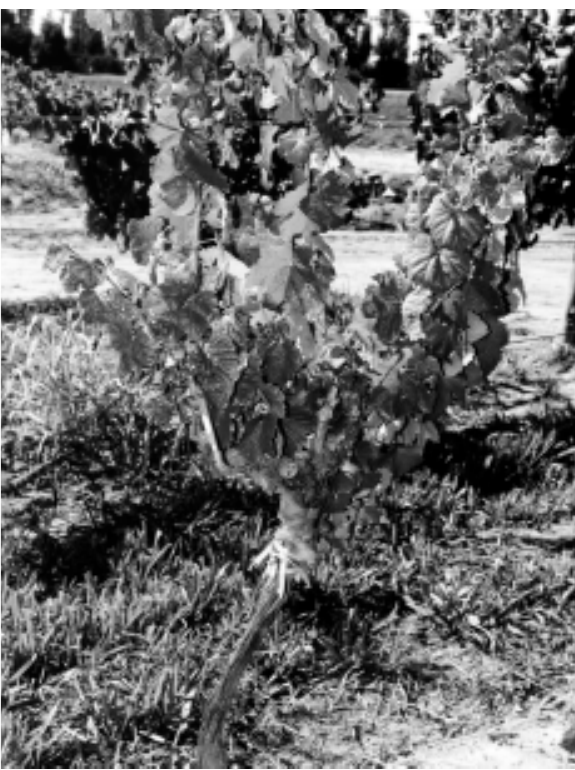
Fig. 2. Formation of wood decay at the inoculation point in a vine inoculated with Phellinus sp. (vine No.